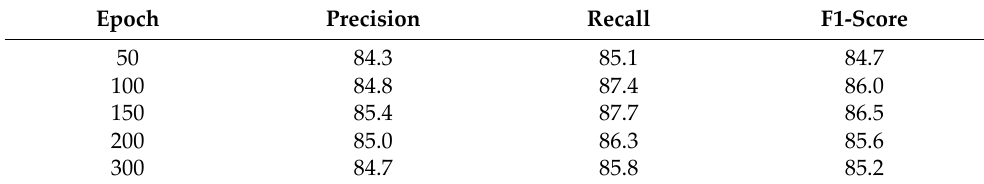
Table 9. Experimental results with different